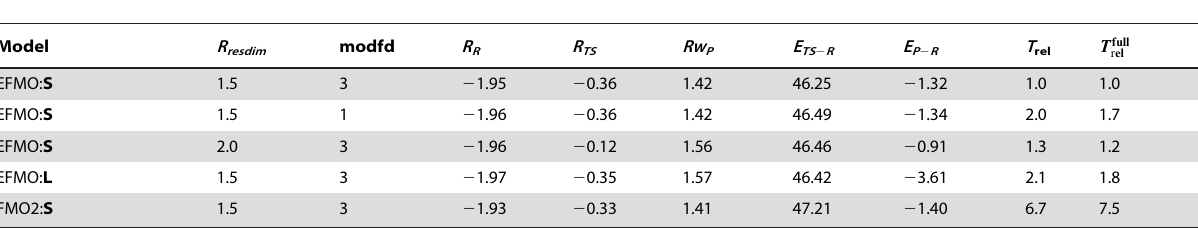
Table 1. EFMO-RHF and FMO2-RHF results for chorismate mutase.